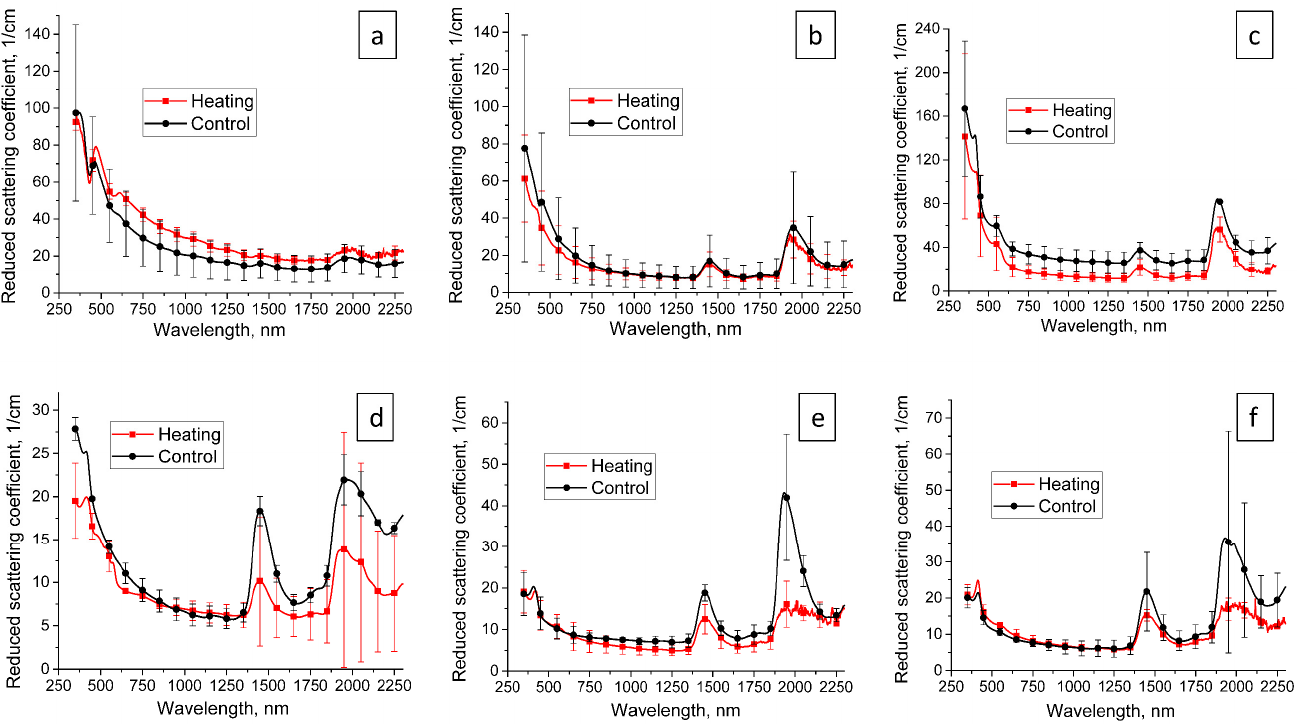
Figure 8. Spectra of the reduced scattering coefficient of tumor and surrounding tissues from experimental and control groups: ( a ) skin, ( b ) sub-skin layer, ( c ) tumor capsule, ( d ) tumor top, ( e ) tumor center, and ( f ) tumor bottom.